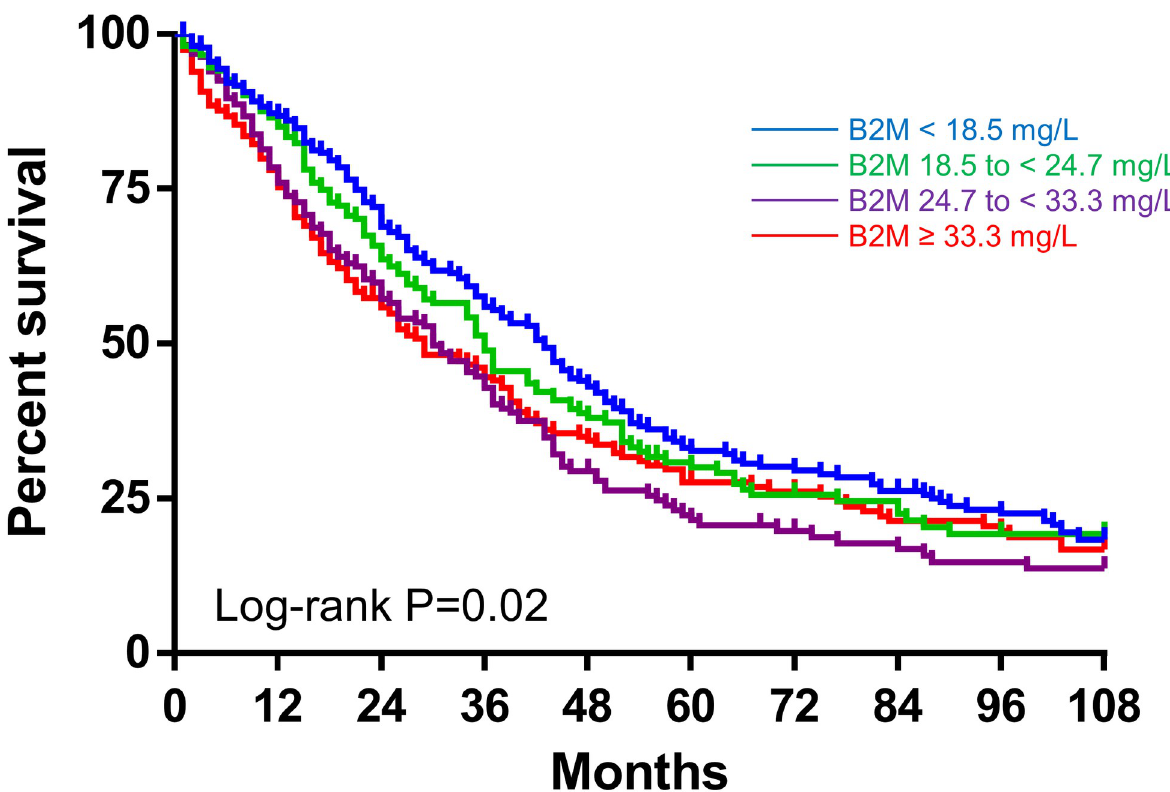
Fig 5. Kaplan-Meier curve of all-cause mortality among patients continued PD. This parameter was compared between four groups according to serum B2M. Abbreviations: B2M, β 2